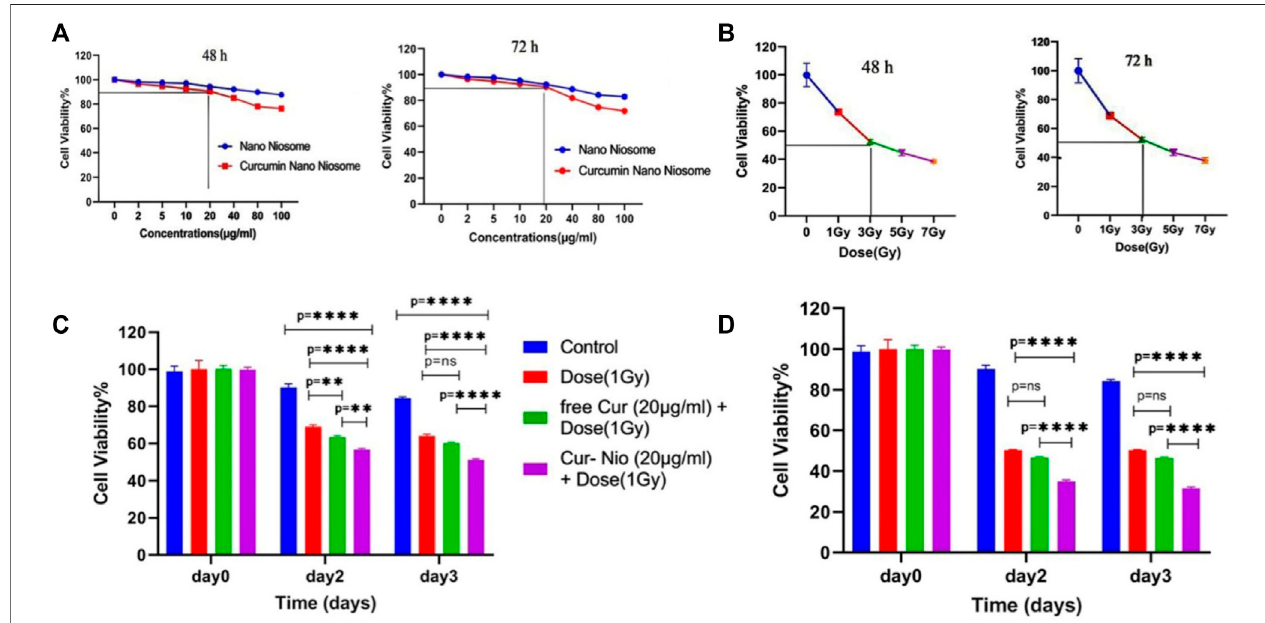
FIGURE 5 | Viability of MCF7 cells treated with blank nanoniosomes and Cur-Nio at 48 and 72 h (A) . Dose-response curves of MCF7 cells that were exposed to increasingirradiationdosesat48and72 h (B) .TheviabilityofMCF7cellstreatedwithirradiationwithorwithout20 μ g ml − 1 offree-Cur (C) andCur-Nio. (D) NSstandsfor “ not statistically signi fi cant; ” ** p < 0.01 and **** p < 0.0001.